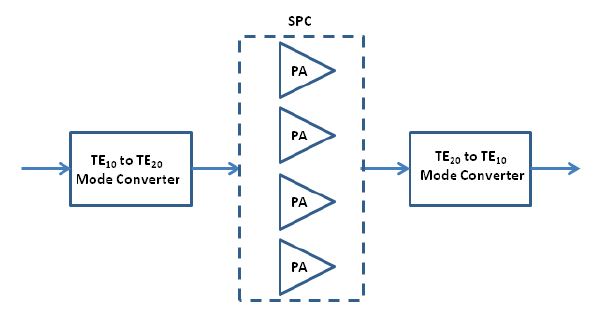
Figure 9: Blocks diagram of the SPC application.